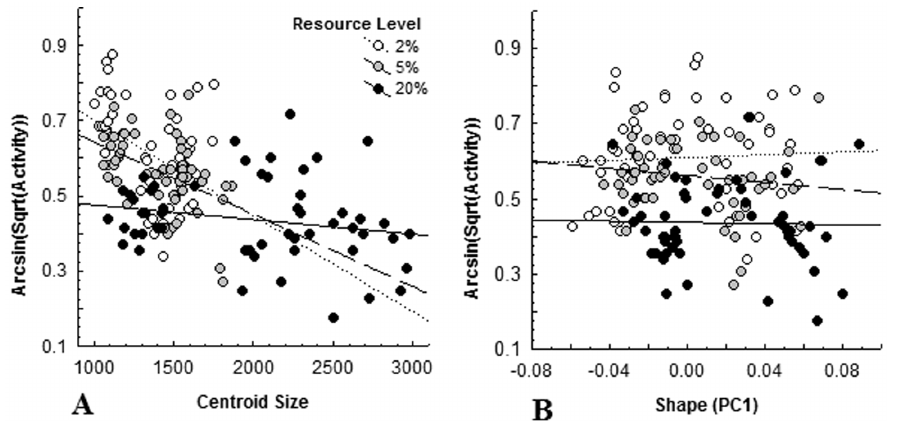
Figure 4. Relationship between behavioural (activity (%)) and morphological (A: centroid size, B: shape (PC1)) responses of Northern leopard frog tadpoles ( Lithobatespipiens ). to variation in predation risk averaged by week, across three weeks of experimentation, at three resource level treatments (2%: severe restriction, 5%: moderate restriction, 20%: saturation).